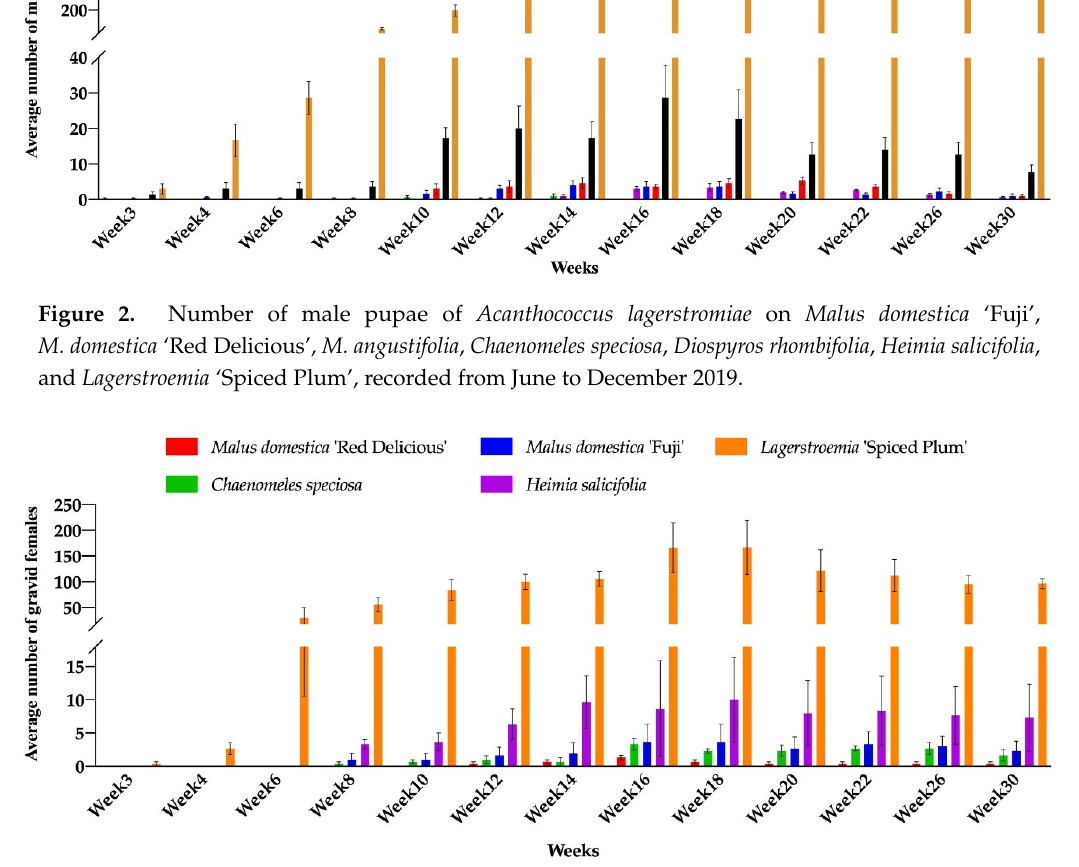
Figure 3. Number of gravid females of Acanthococcus lagerstromiae on Malus domestica ‘Fuji’, M. domestica ‘Red Delicious’, Chaenomeles speciosa , Heimia salicifolia , and Lagerstroemia ‘Spiced Plum’, recorded from June to December 2019. Table 3. The number of male pupae and gravid females, and sex ratio (male to female ratio) on five plant species and cultivars infested with Acanthococcus lagerstromiae in September 2019. Plant Species No. Male Pupae No. Gravid Females Sex Ratio Lagerstroemia ‘Spiced Plum’ 555.7a Z 166.5a